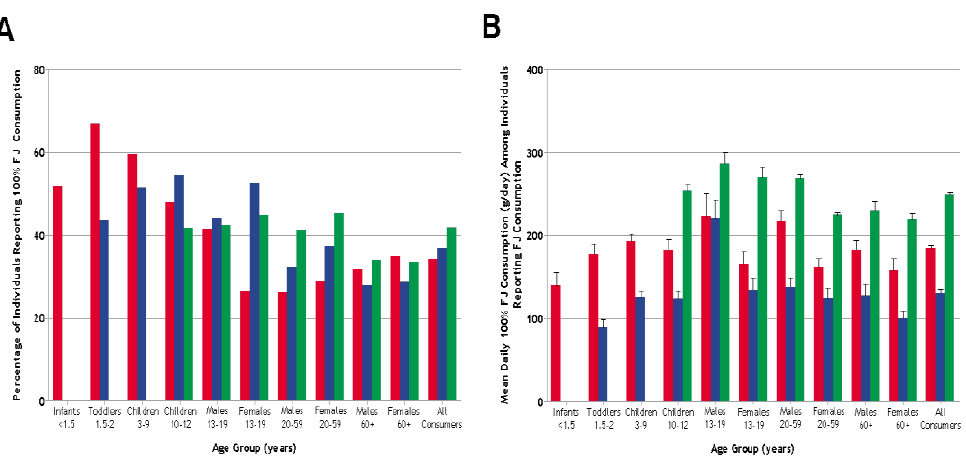
Figure 1. ( A ) Percentage of individuals reporting consumption of 100% fruit juice (FJ); ( B ) Average daily intakes (mean ± SEM) of 100% FJ (g / day) in individuals reporting consumption of 100% FJ. The “all consumers” category does not include infants < 1.5 y for the UK and children < 10 y for Brazil, as these individuals were not included in the respective surveys. Red bars = U.S.; blue bars = UK; green bars = Brazil.